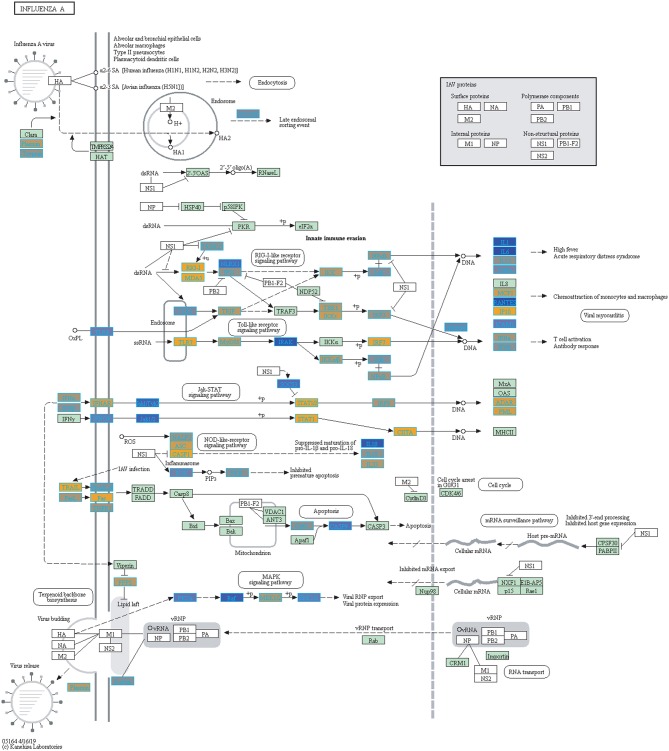
Highlighted Influenza A KEGG Pathway (hsa05164) with Enriched Genes from the LRT Analysis (Bonferroni-adjusted p < 0.05) for Influenza Vaccinated Subjects (47–49). Yellow-colored genes are up-regulated and blue-colored genes are down-regulated in Influenza Vaccinated Subjects.